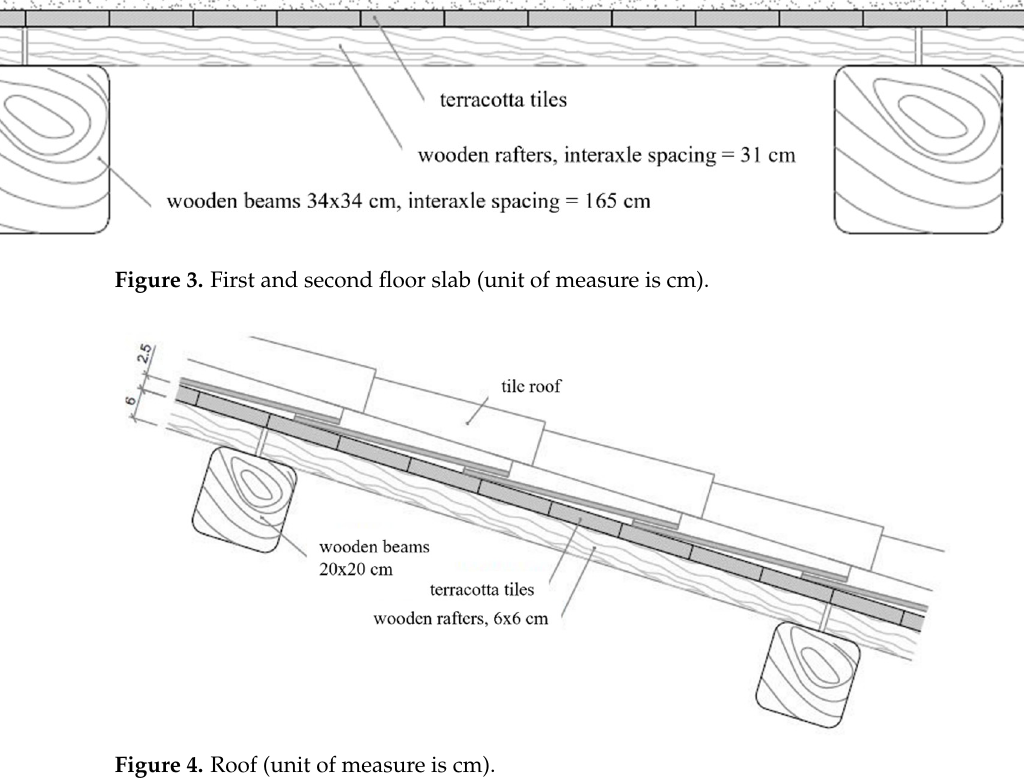
Figure 4. Roof (unit of measure is cm).